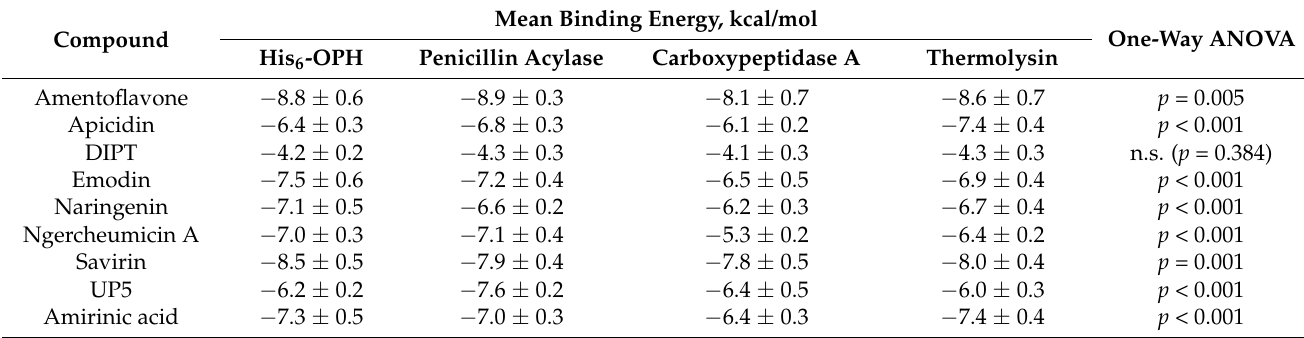
Table 1. Binding energy (affinity) of selected compounds to surfaces of